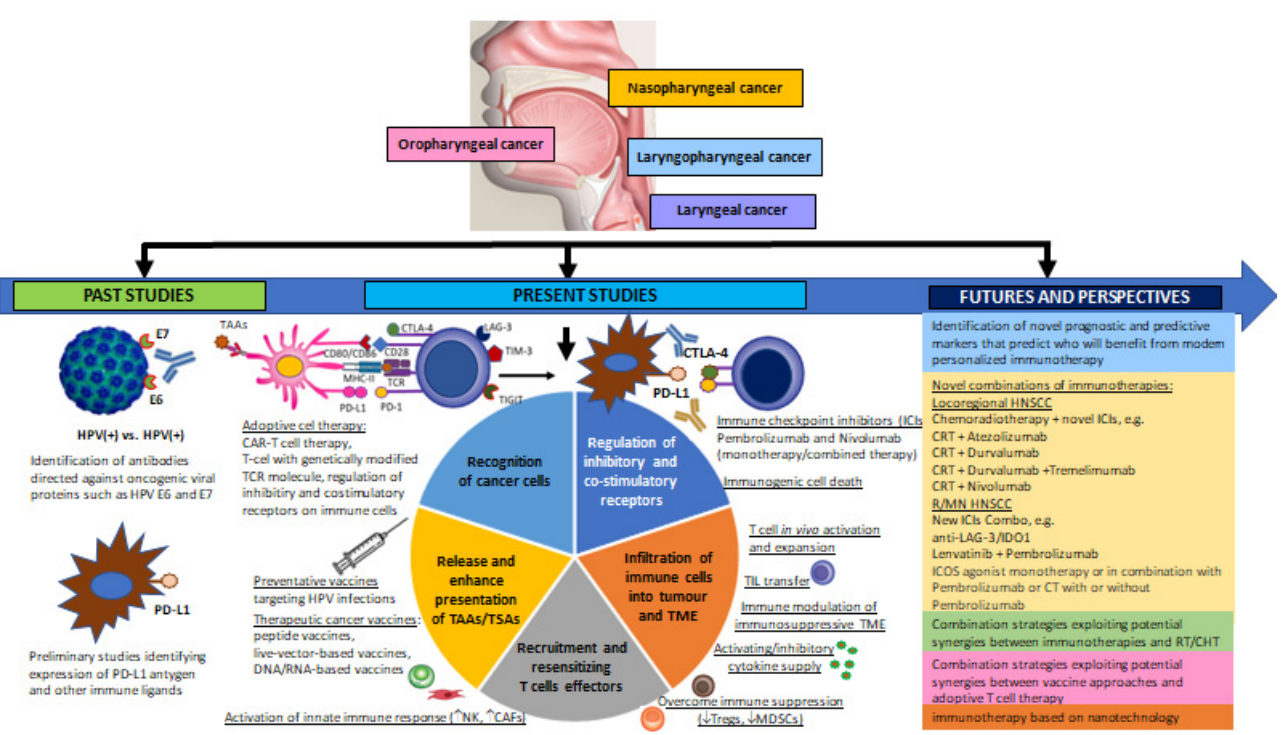
Figure 5. Summary of recent and new discoveries in the field of HNSCC immunotherapy and their relation to previous knowledge. Previous studies have indicated the role of oncogenic viruses HPV 16, 18, 31, 33, 35, etc., in the development of mainly the oropharynx and oral cavity, Additionally, immune markers on HNSCC tumour cells and circulating antibodies targeting viral antigens were identified. It has also been indicated that immunological markers may have a significant prognostic